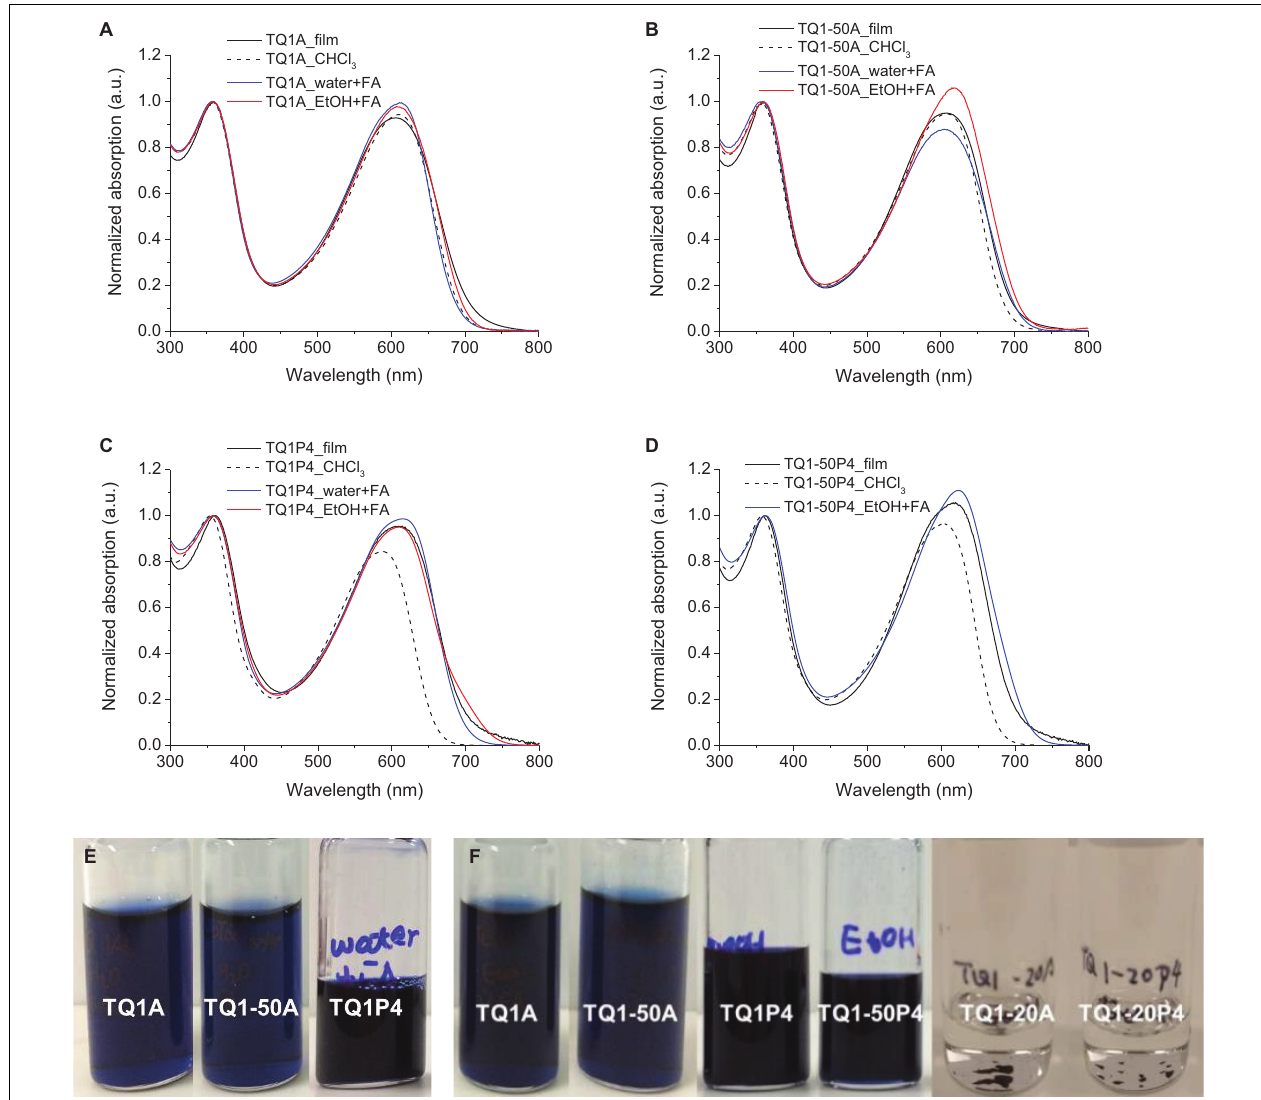
FIGURE 1 | Normalized UV–vis absorption spectra of (A) TQ1A, (B) TQ1-50A, (C) TQ1P4, and (D) TQ1-50P4 in different solvents and in the solid state. Photographs of (E) polymer in water + 3% FA solution, (F) polymer in EtOH + 3% FA solution.